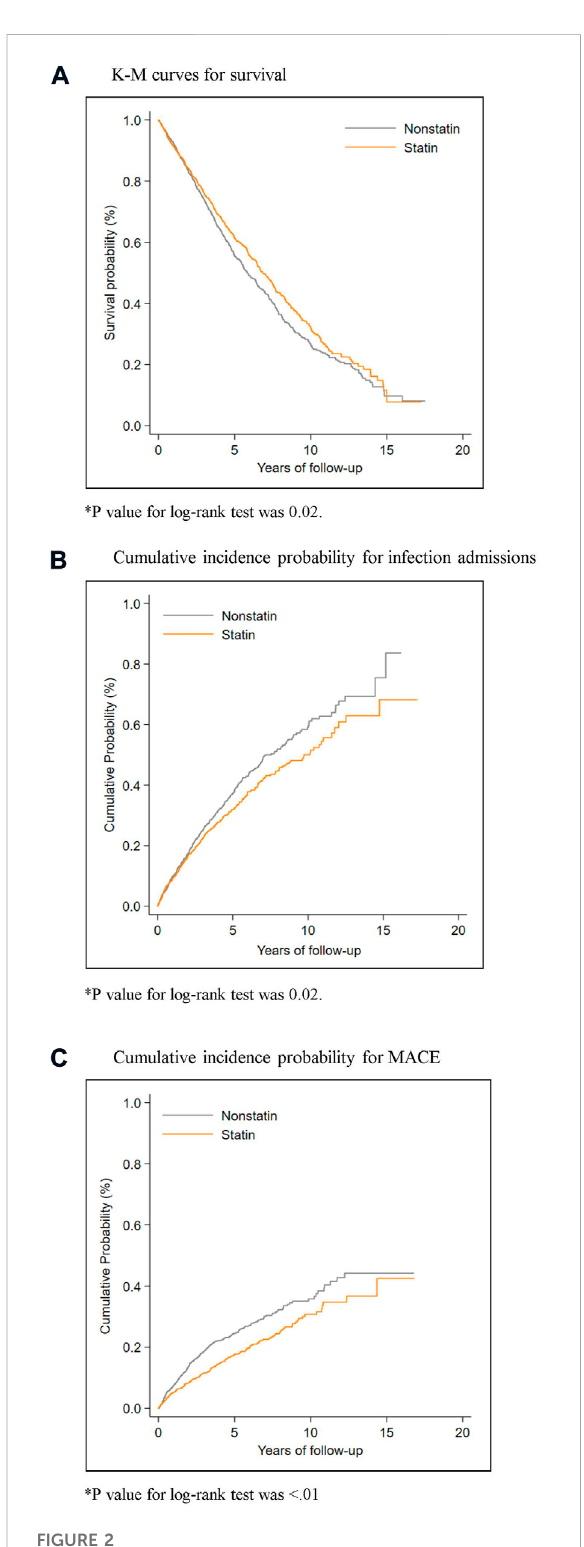
FIGURE 2 Cumulative probability curves for primary outcomes by statin exposure